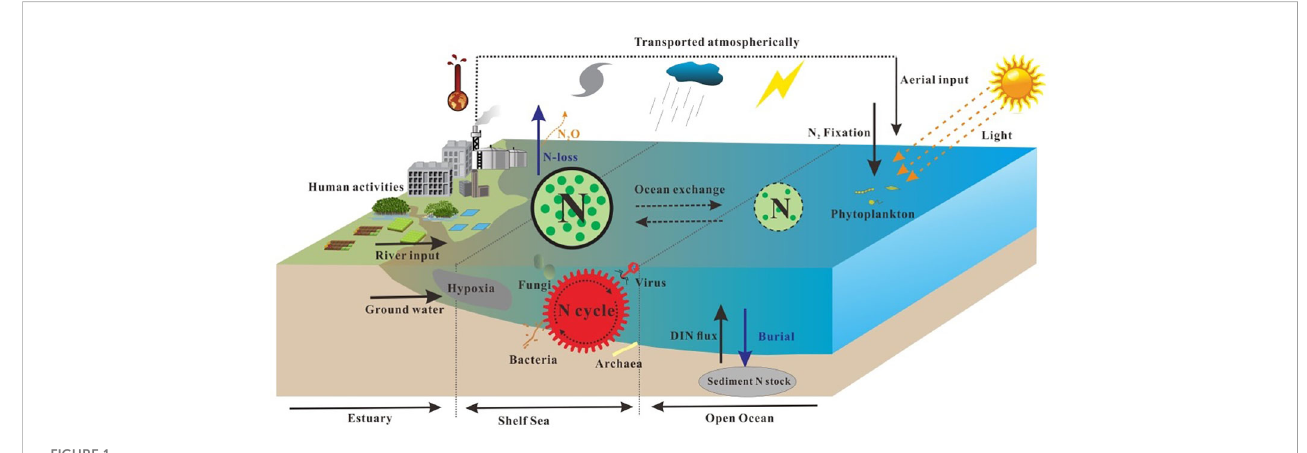
FIGURE 1 N cycle in estuarine and coastal